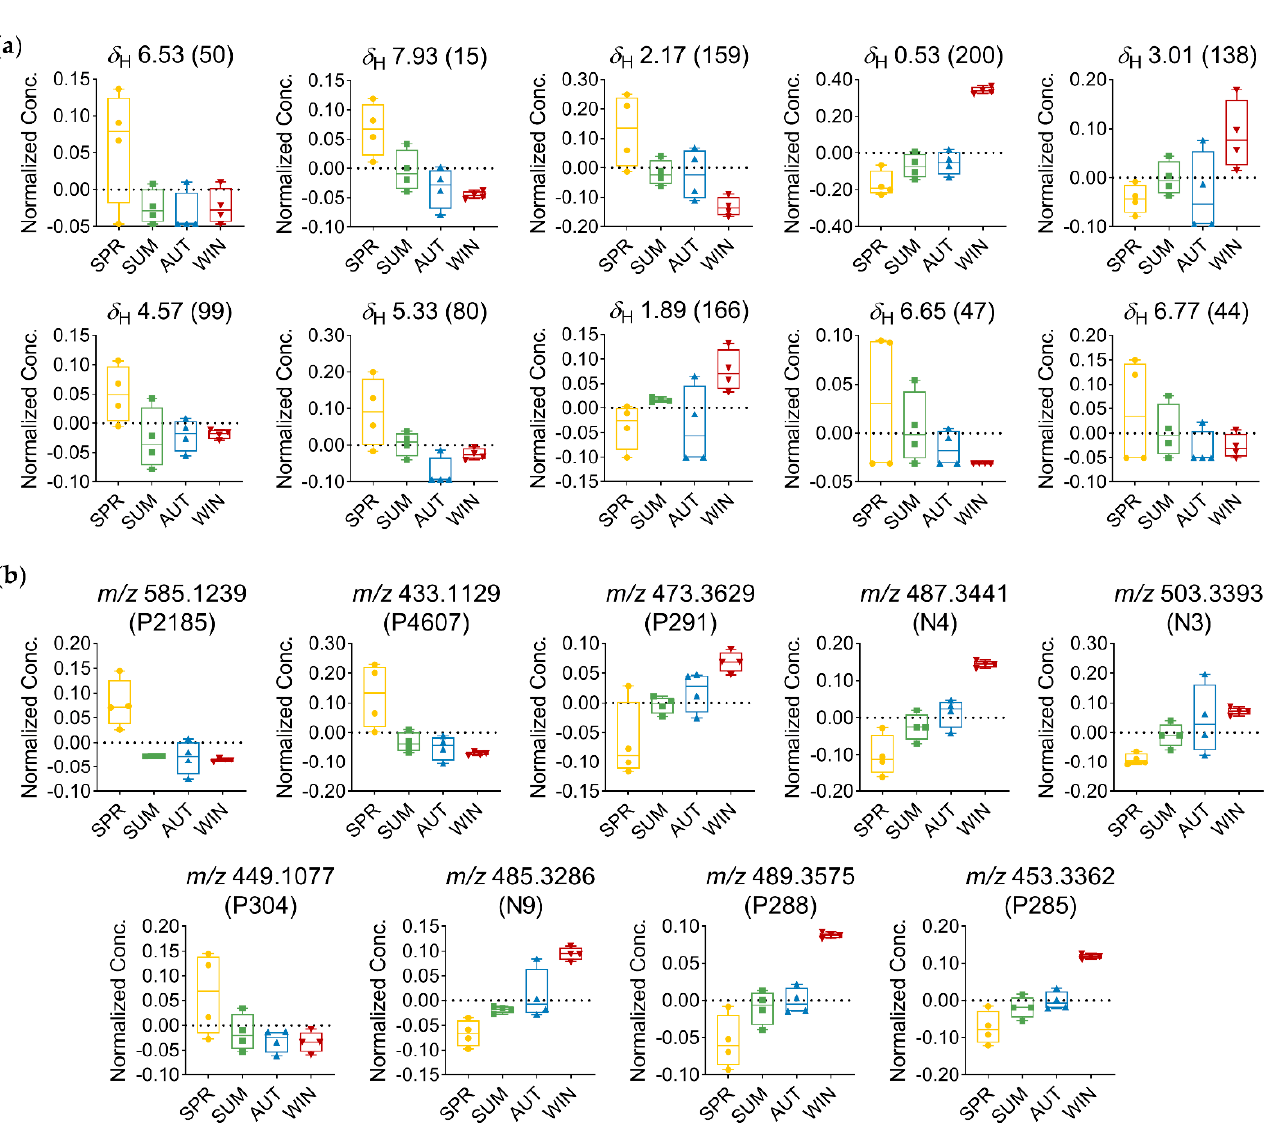
Figure 6. Relative distribution of discriminant metabolites in T. catappa extracts: ( a ) Box plots representing the concentration values of discriminant metabolites signals with FDR ≤ 0.05 ( δ in ppm—ID) using MS-NMR fused data; ( b ) box plots representing the concentration values of discriminant metabolites signals with FDR ≤ 0.05 using MS data ( m / z —MZmine ID). Season samples: Summer (SUM), Autumn (AUT), Winter (WIN), and Spring (SPR).